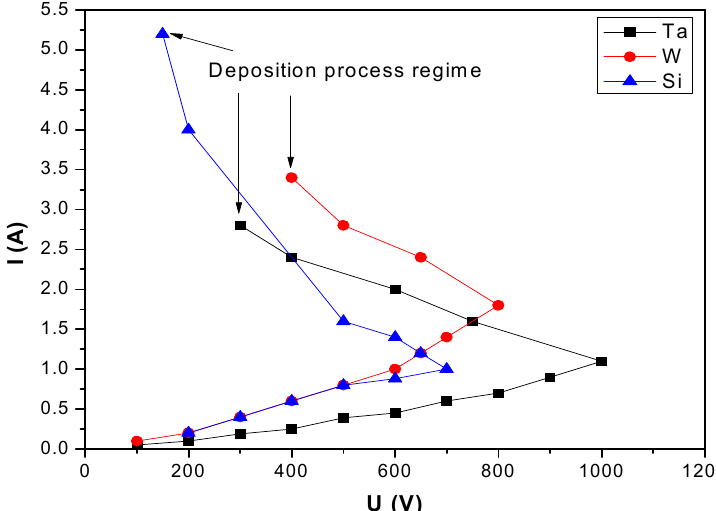
Figure 2. Current–voltage (I–V) characteristics of thermionic-vacuum-arc (TVA) plasma ignited using Ta, W, and Si anodes.